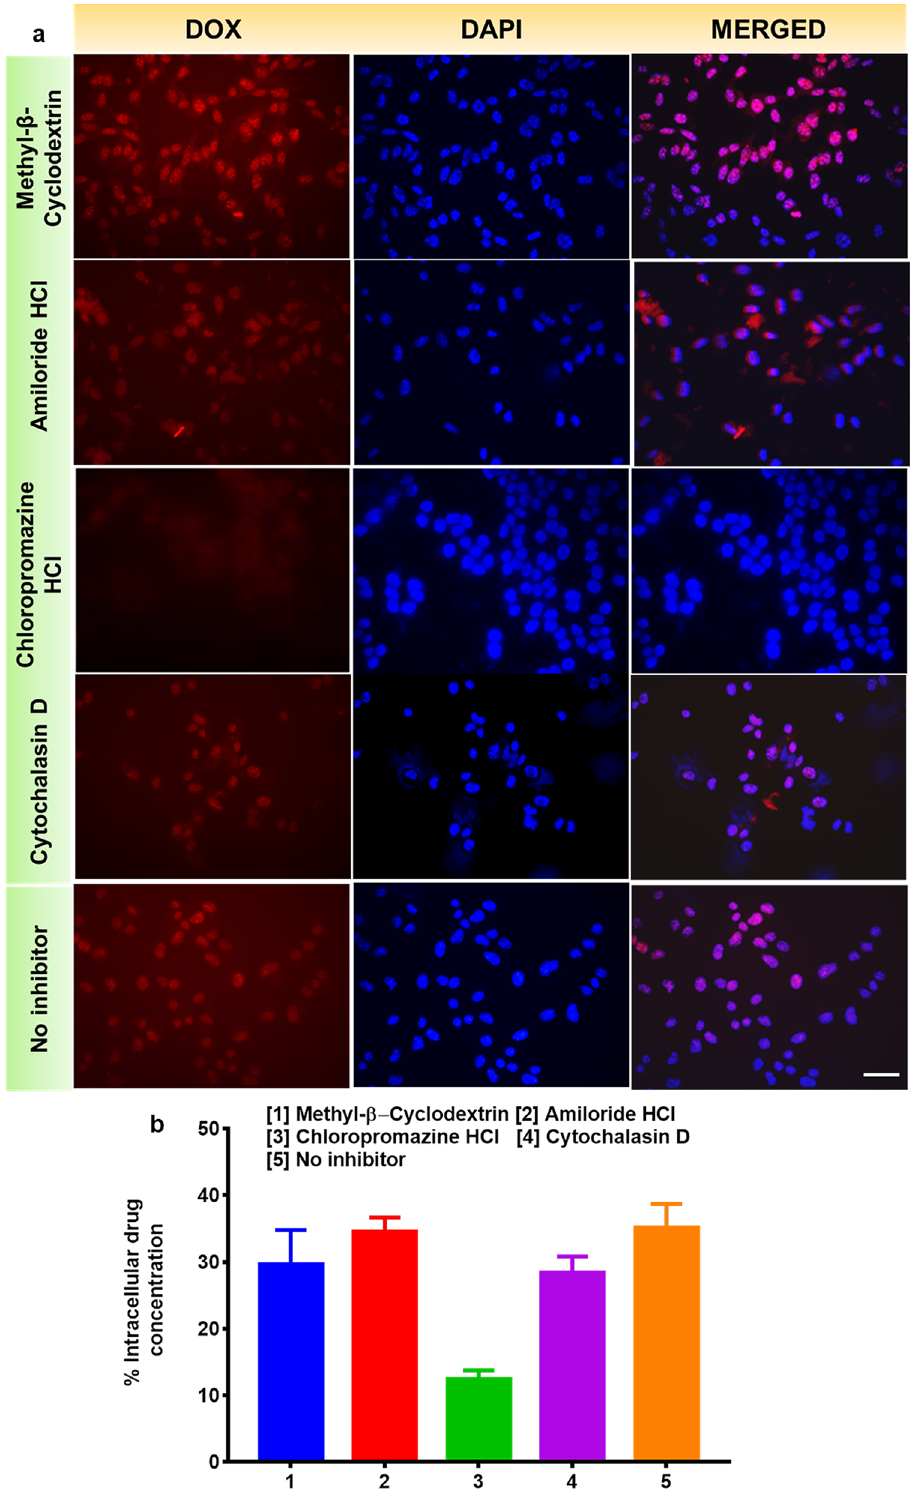
Figure 3. Confluent A549 cells were pre-treated with endocytotic inhibitors Methyl β cyclodextrin, Cytochalasin D, Chlorpromazine HCl and Amiloride HCl for 2 h, then treated with DOX@CM-PIONPs. ( a ) Fluorescent microscopic images of treated cells represent the DOX@CM-PIONPs were mediated by the clathrin-mediated endocytosis although combined effects of clathrin and macropinocytosis and ( b ) quantitative cellular uptake using HPLC suggested the clathrin-dependent endocytosis of nanoparticles. Scale bar corresponds to 50 µm. The experiments were carried out in triplicates and error bars denote standard